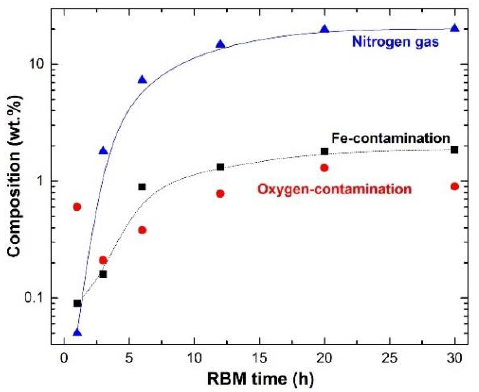
Figure 32. Nitrogen, oxygen, and Fe contents on the milled powder samples obtained after different stages of RBM time.